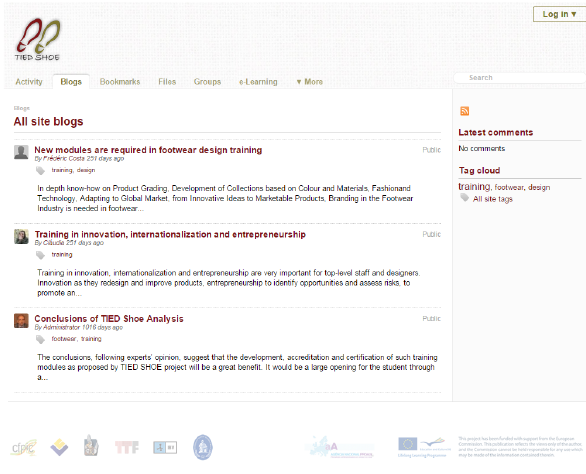
Fig. 1 The TIED Shoe